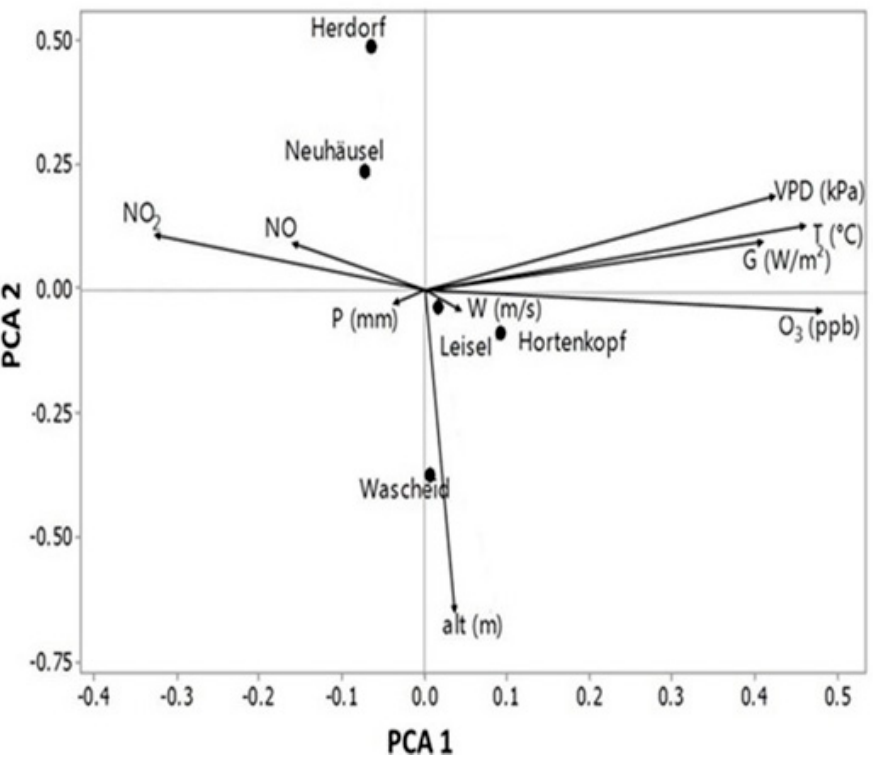
Figure 5. The PCA ordination of meteorological and pollution data in hourly resolution. Ordination diagram with 8 components and 5 sites. PCA is performed on the correlation matrix in which each variable is scaled to have its sample variance equal to one. For the correlation matrix, the eigenvectors correspond to principal components and the eigenvalues to the variance explained by the principal components. O 3 (ppb): Ozone concentration, NO 2 and NO (µg/m 3 ): nitrogen dioxide and nitrogen monoxide, T (°C): temperature, VPD (kPa): Vapor pressure deficit, G (W/m 2 ): global radiation, P (mm): precipitation, W (m/s): wind speed and altitude (m) at five sites during the time series 1998–2019 in Rhineland-Palatinate, Germany.